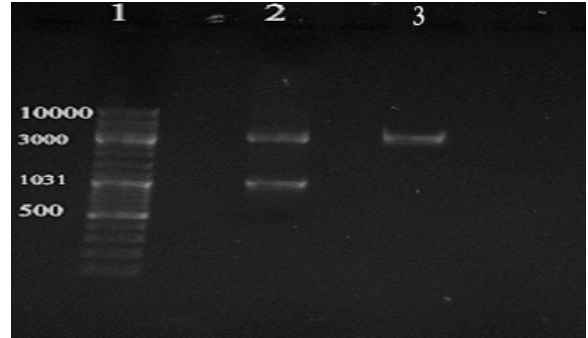
Figure 3. Agarose gel electrophoresis analysis of the double digestion of plasmid. Lane 1: DNA marker SM0333. Lane 2: Double digestion of pWB980- dfpse plasmid with Bam HI and Hin dIII.